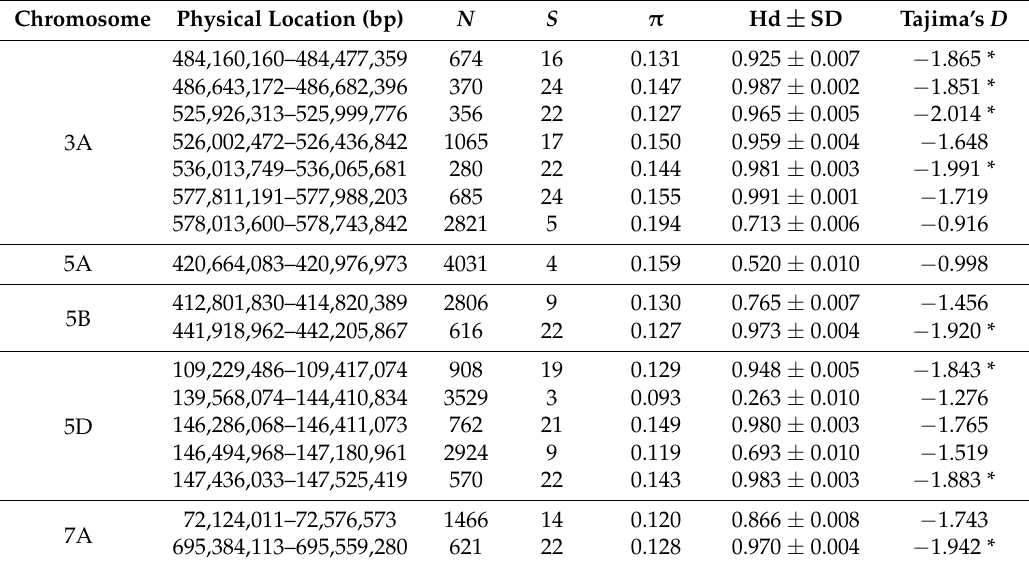
Table 2. Nucleotide polymorphism of the repeat features of Ta-3A1 in wheat